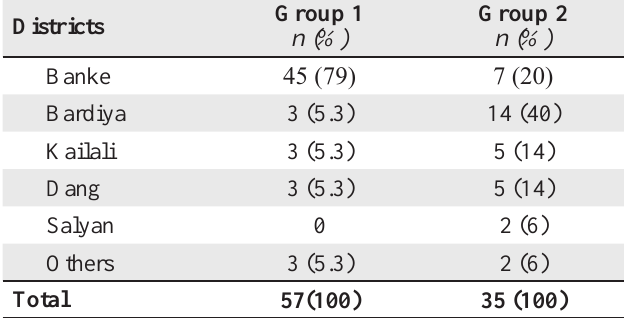
Table 2: Distribution of Eclamptic patients according to